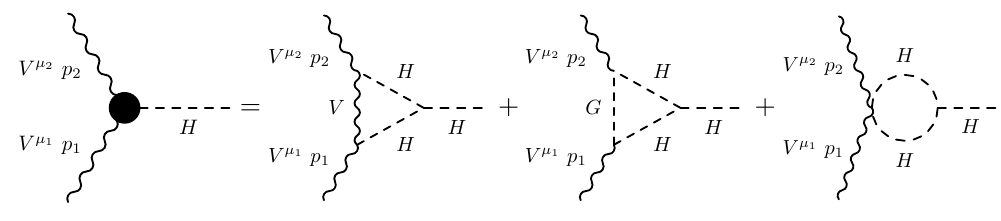
Figure 19 . Feynman diagrams contributing to the V [ HV V ] form factor at one loop. HV V